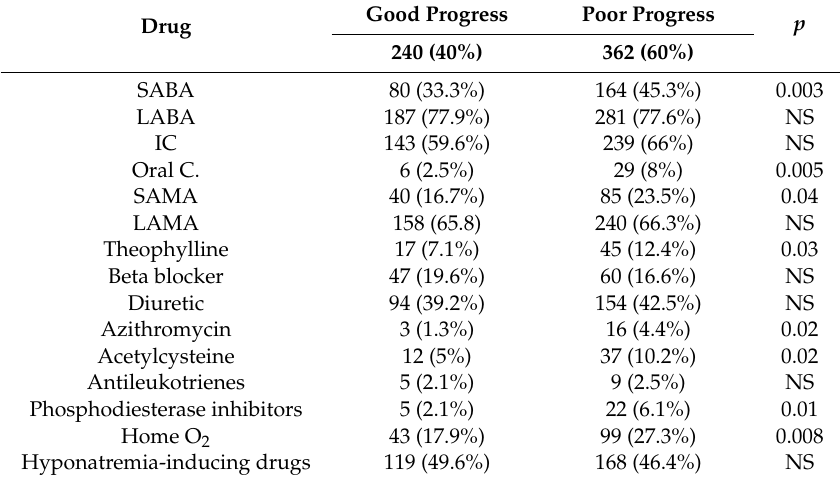
Table 2. Baseline treatment of patients.